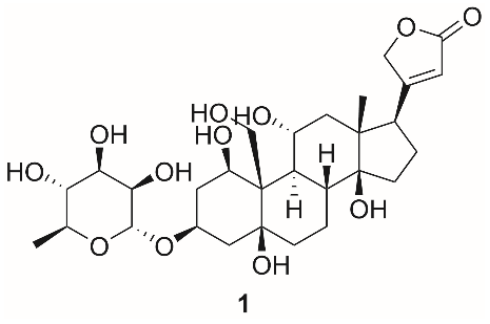
Figure 4. Chemical structures of ouabain ( 1 ).